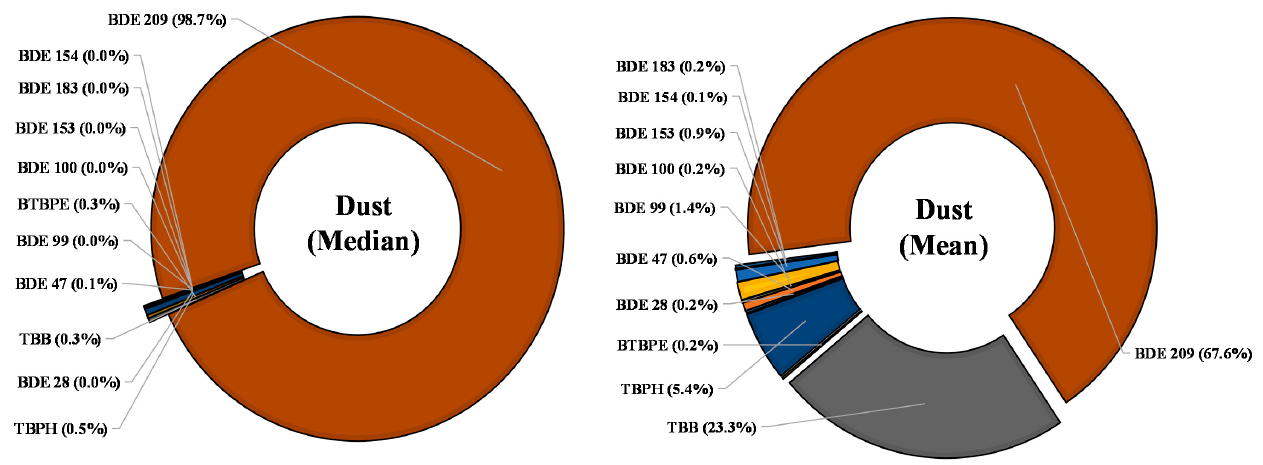
Figure 2. Profile of studied BFRs with median and mean values in indoor dust samples from Saudi children’s rooms.